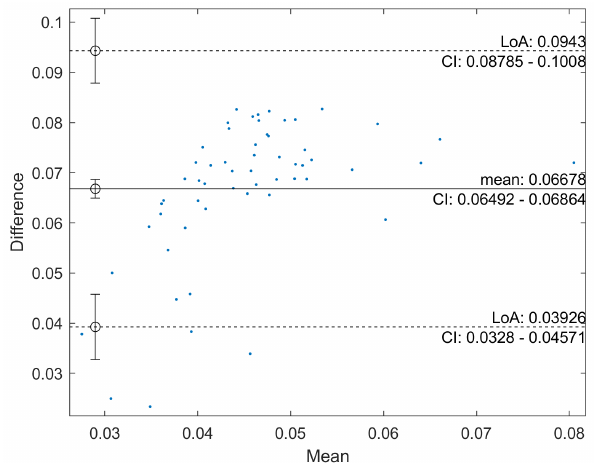
Figure 15. Bland–Altman plot shows the agreement between spatiotemporal features (horizontal deviation in the position of the vertical neck line betwen Heads and SpineBase joints) for subjects calculated using RealSense and IK analysis. The reference line at the mean is represented by the red solid line, and the top and lower limits of agreement are represented by the two black dashed